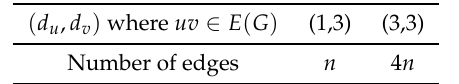
Table 1. The edge partition of the graph G for k = 1.